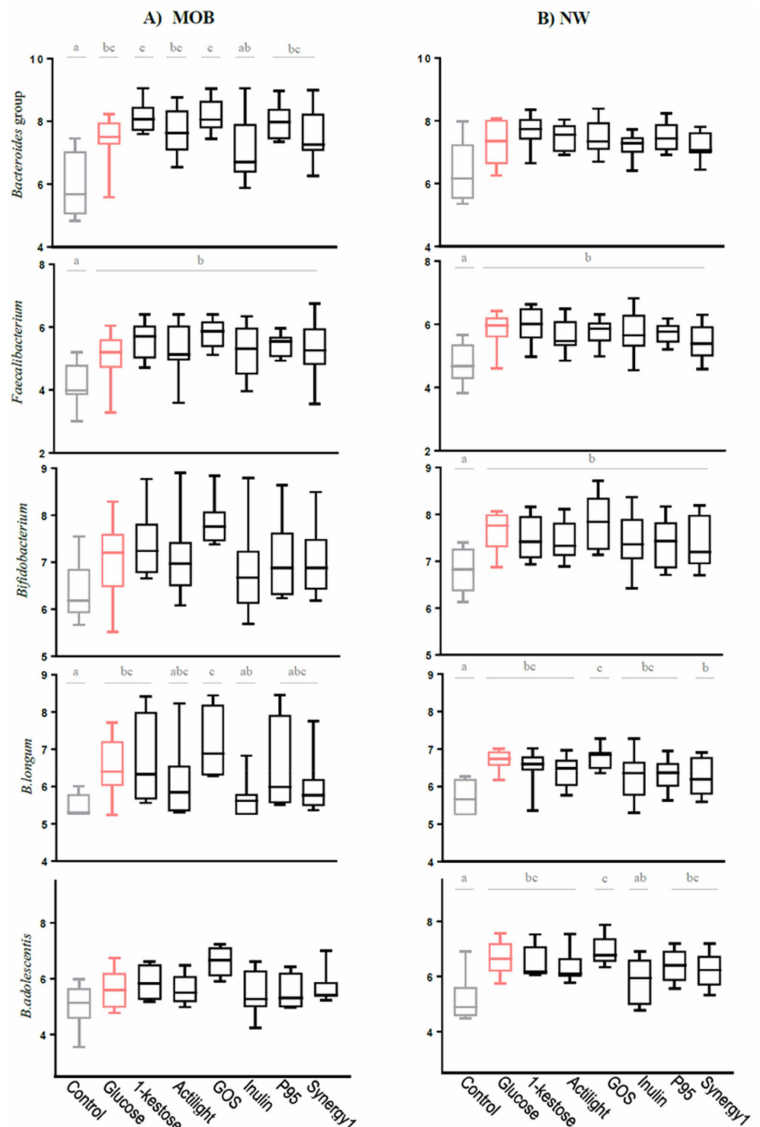
Figure 2. Absolute levels (Log CFU / mL) of fecal microbial groups determined by qPCR after fecal cultures of ( A ) MOB and ( B ) NW subjects. For each microbial group, the box and whiskers plot represent median, interquartile range and minimum and maximum values obtained in each human group (NW or MOB). Di ff erent letters above the boxes indicate significant di ff erences ( p -value < 0.05) among carbon sources for the microbial groups